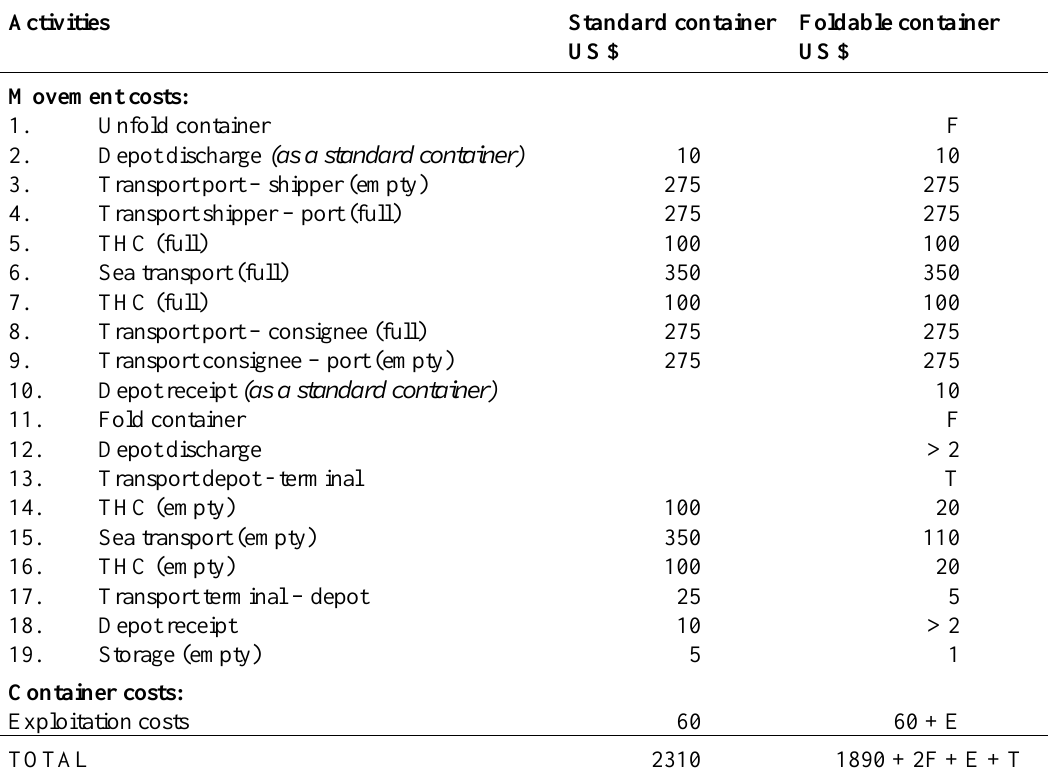
Table A1. Chain costs for the transport of a standard and foldable 20 ft container according to the port-to-port concept (in US